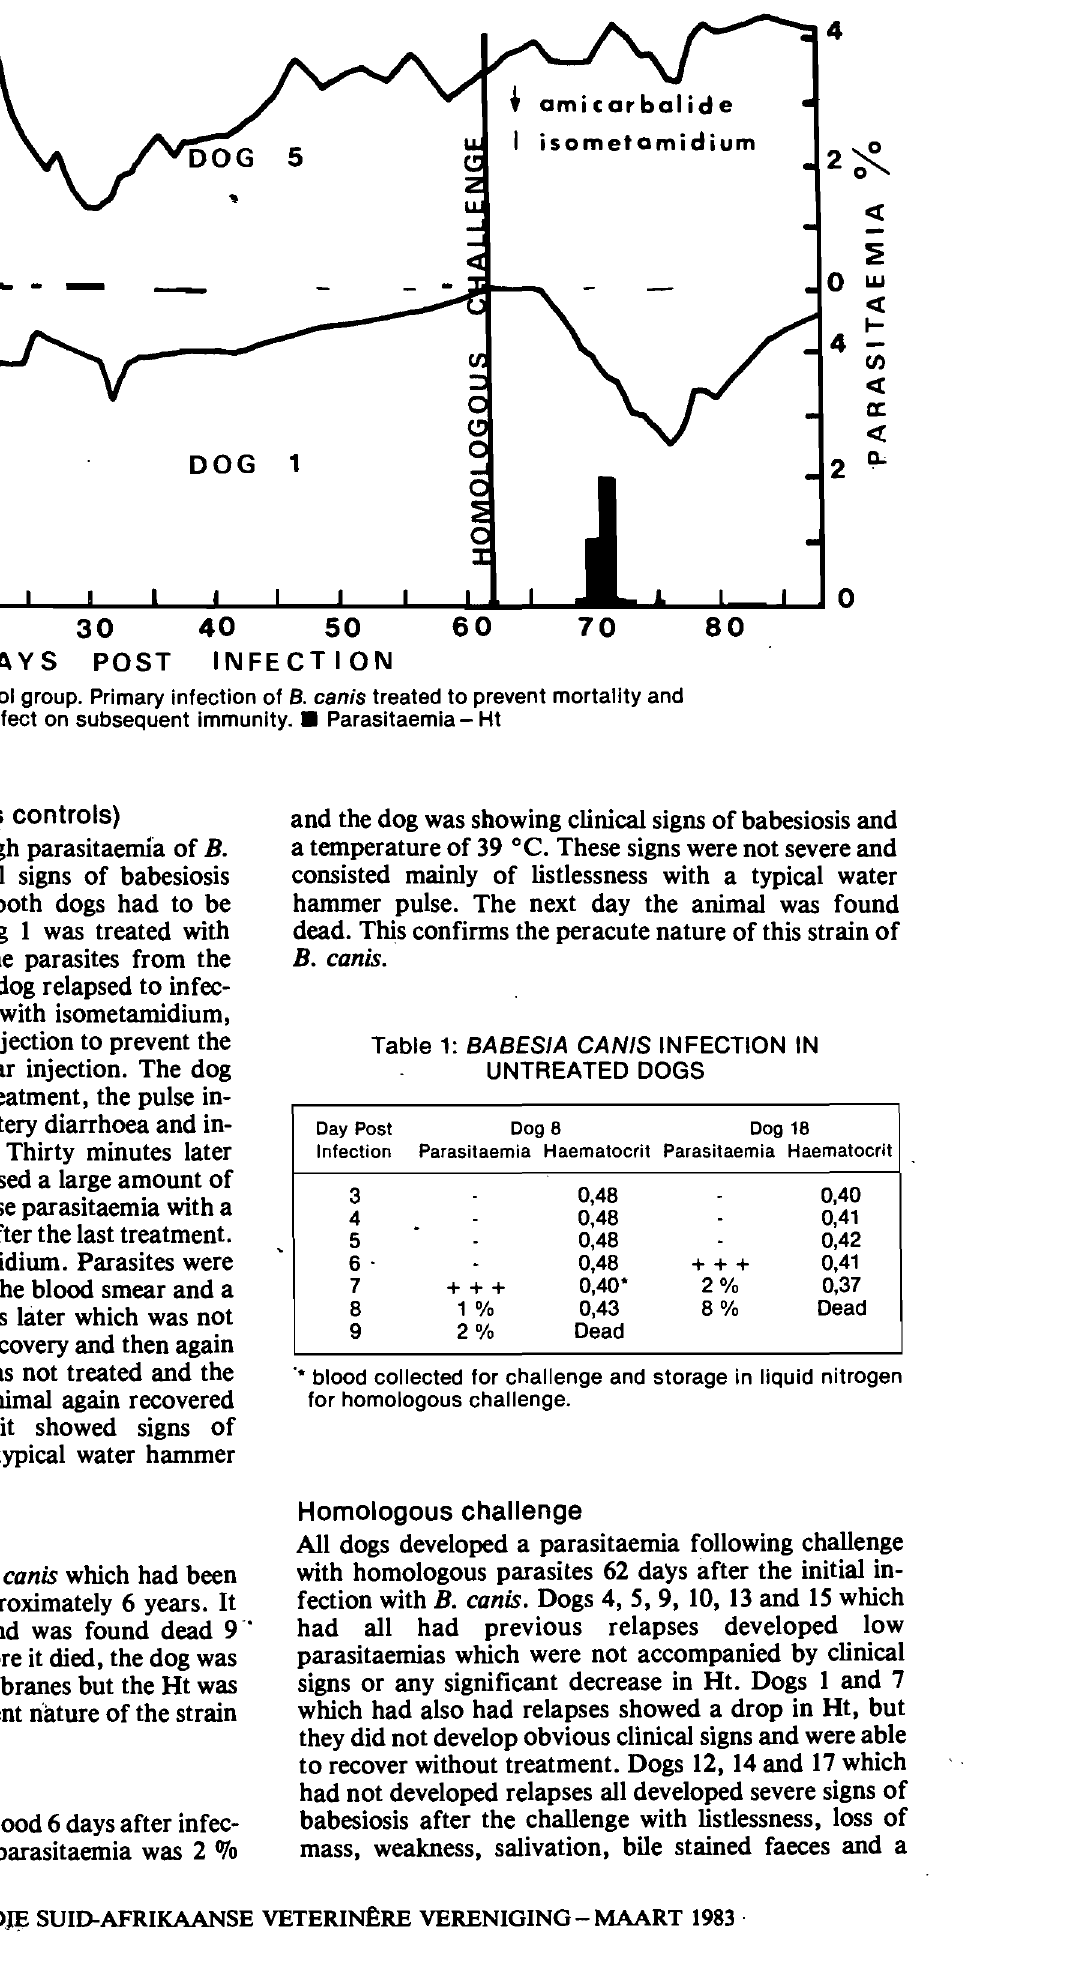
TYDSKRIF VAN D.JE SUID-AFRlKAANSE VETERIN~RE VERENIGING-MAART